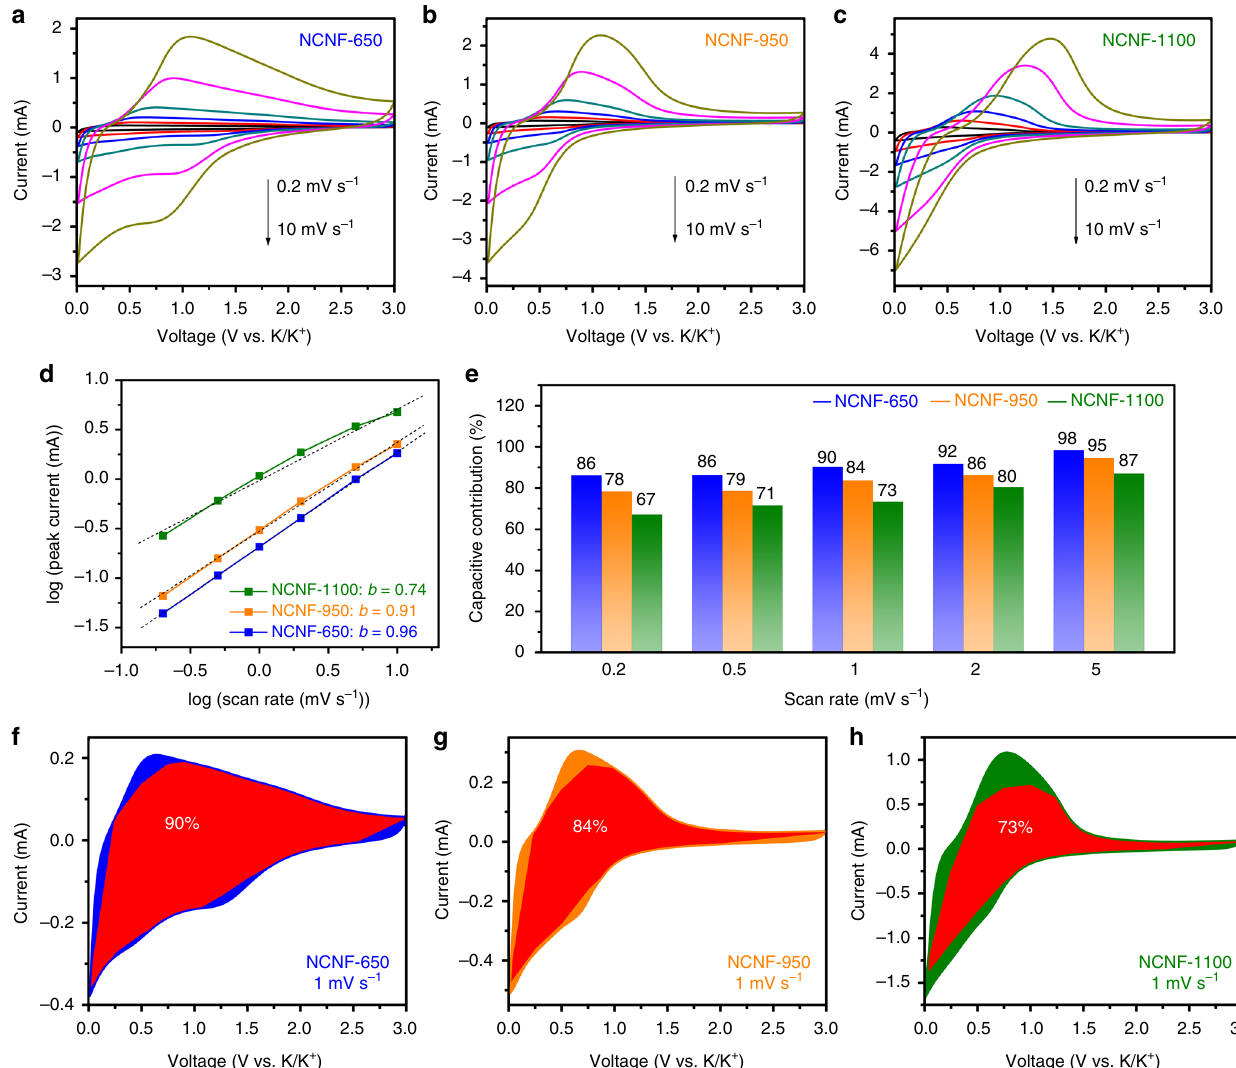
Fig. 4 Quantitative analysis of surface-dominated K-storage in NCNFs. CV curves of NCNF-650 ( a ), NCNF-950 ( b ), and NCNF-1100 ( c ) at various scan rates of 0.2 to 10 mV s – 1 . d b value determination. e Contribution of the surface process in the NCNFs at different scan rates. Contribution of the surface process at scan rate of 1 mV s – 1 in NCNF-650 ( f ), NCNF-950 ( g ), and NCNF-1100 ( h